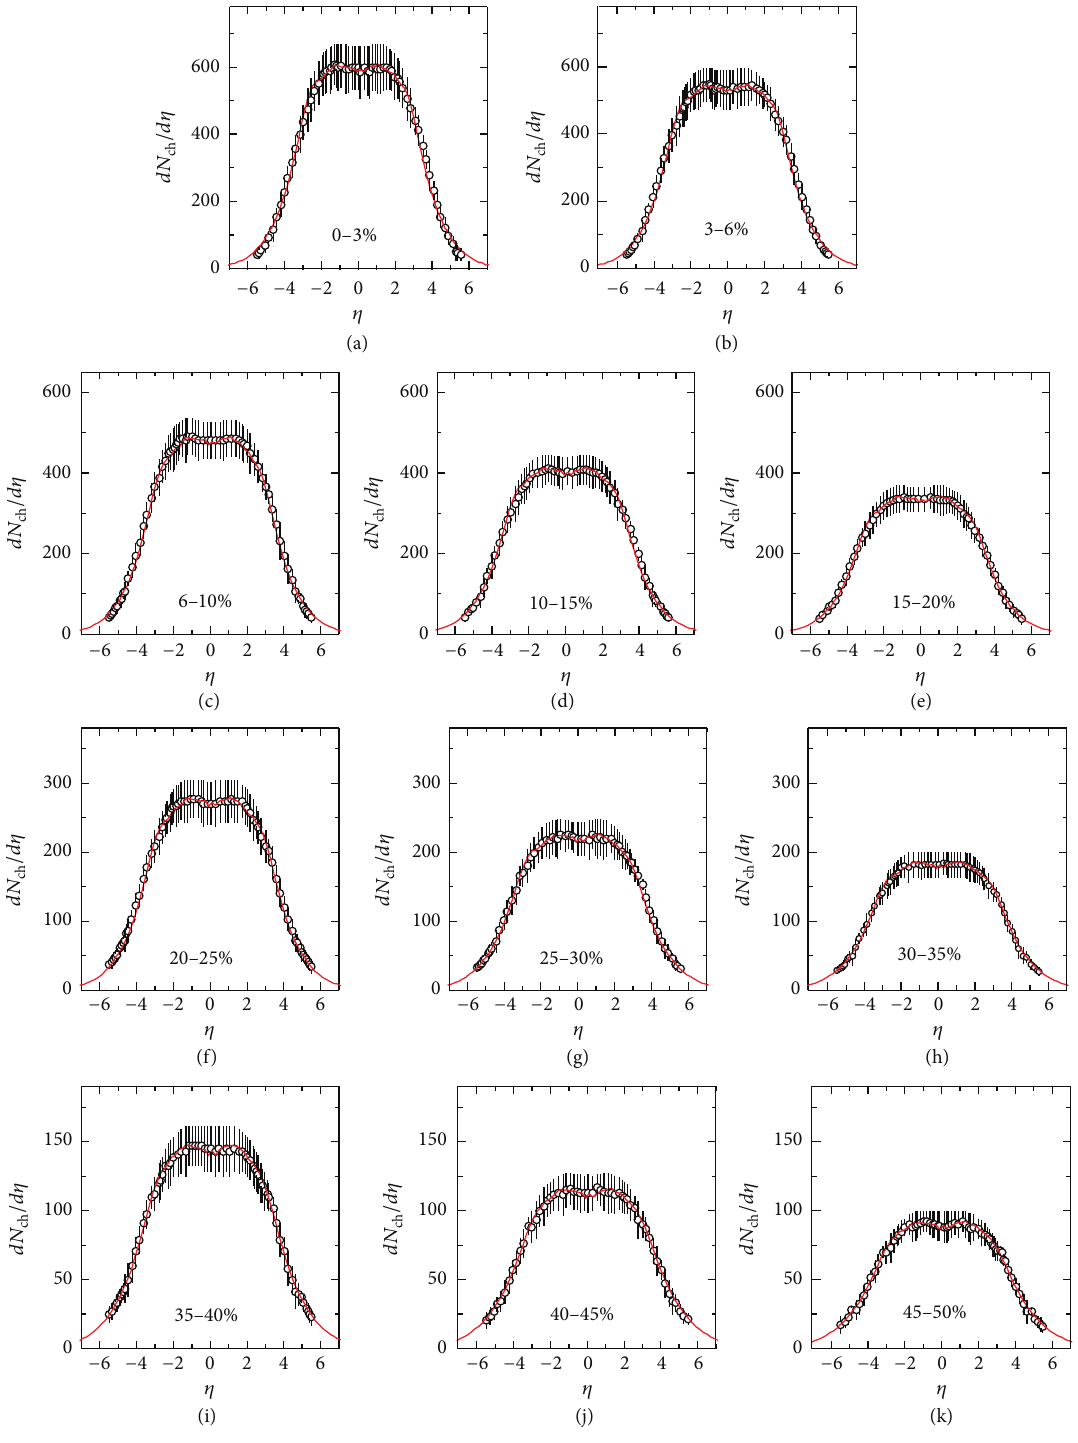
Figure 3: The same as Figure 1 but showing the results of Au-Au collisions at √𝑠 NN = 130 GeV.